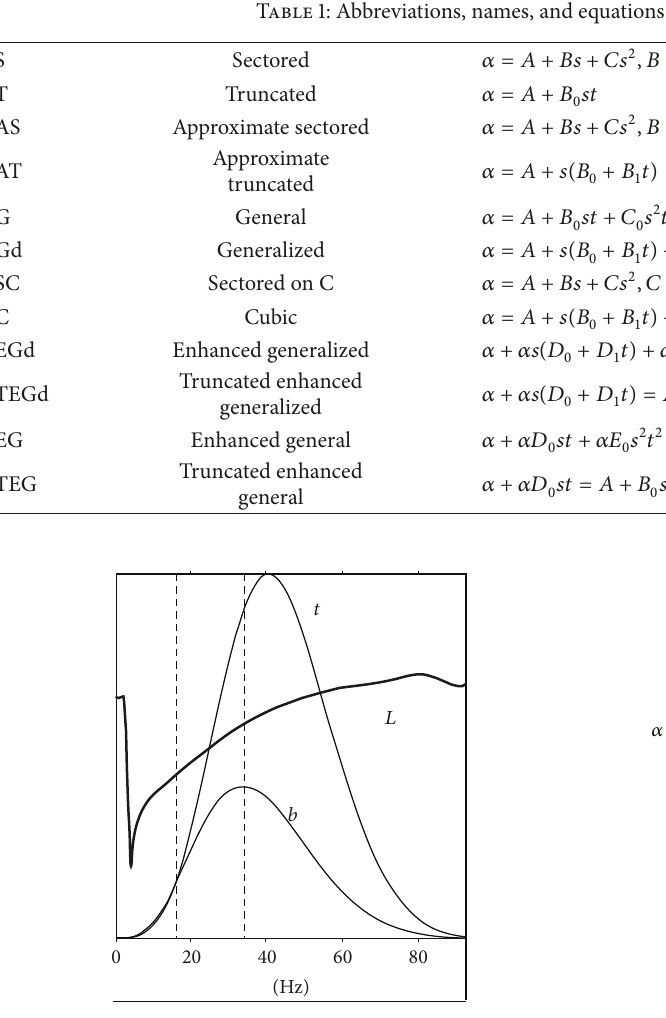
Figure 1: Spectra of impulses reflected from the top ( 𝑡 ) and bottom ( 𝑏 ) of the target layer and the logarithm of their ratio ( 𝐿 ) in normalized units. The interval 𝜂 ≈ const is marked by dashed lines.